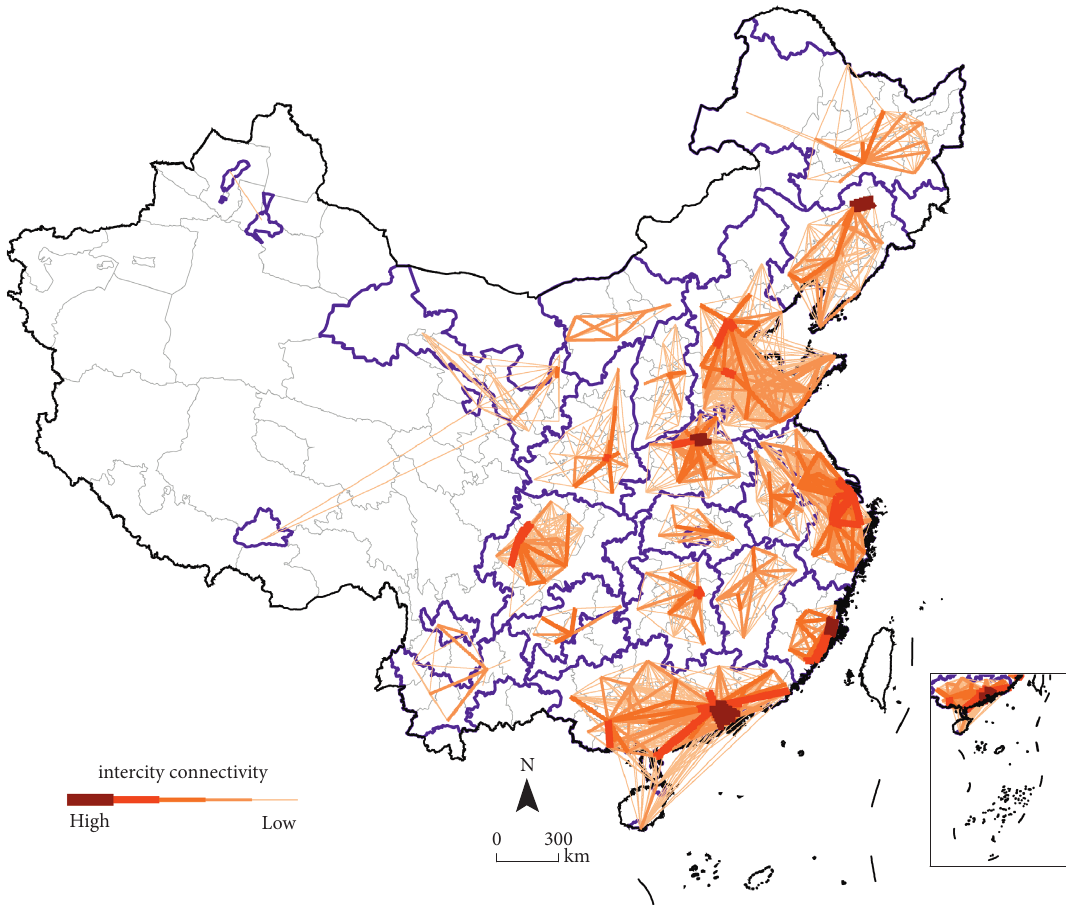
Figure 1: Spatial networks of city groups in China.